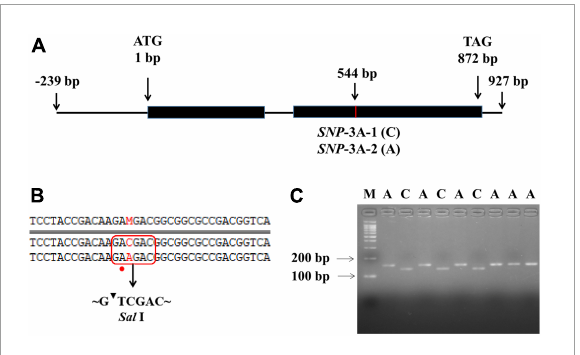
FIGURE3 Nucleotide polymorphisms and molecular marker development of TaMYB5-3A . (A) Schematic diagram of the TaMYB5-3A structure, including two exons and one intron. One SNP was detected in the coding region of TaMYB5-3A . (B) The TaMYB5-3A -dCAPS marker was developed based on the SNP (C/A) at 544 bp. Red rectangle and dot represent the introduction of the Sal I restriction site by base mismatched (A to T), and red letters represent the different bases at 544 bp of the TaMYB5-3A coding region. (C) PCR products were digested by Sal I. The 153 bp fragment amplified from accessions with SNP -3A-1 could be digested by Sal I into 132 bp and 21 bp, while the 153 bp fragment amplified from accessions with SNP -3A-2 could not be digested. M, 100 bp DNA ladder. SNP -3A-1 (C) was the majority in the wheat population, and this sequence was used in subsequent experiments if not specified.